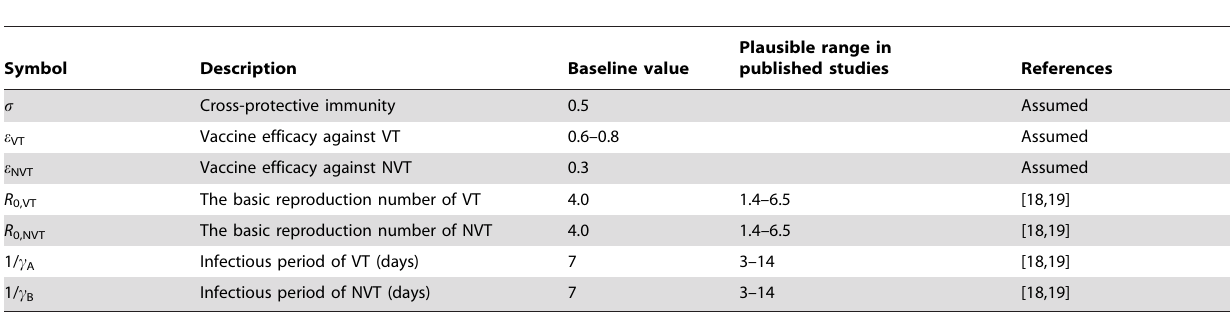
Table 1. Parameter values for the SIR (Susceptible-Infectious-Recovered) model as applied to the epidemiological dynamics of enterovirus 71.